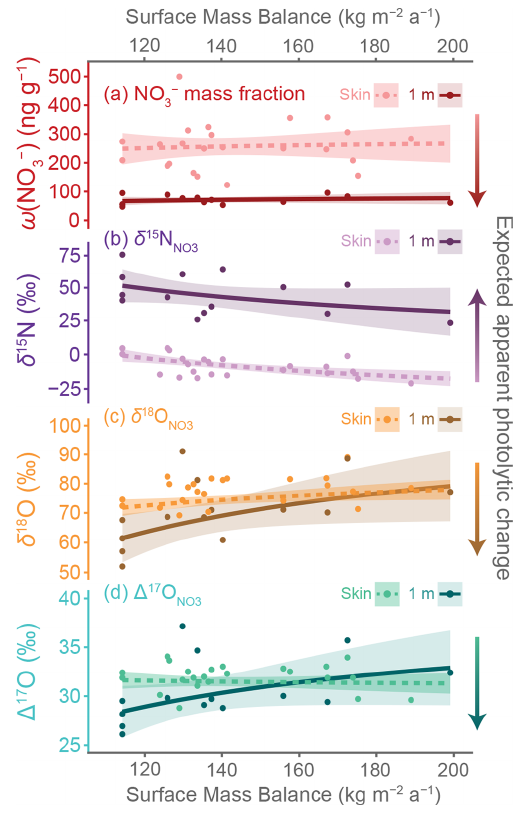
Figure 5. Spatial relationships between nitrate variables and site surface mass balance (SMB). Linear regressions of (a) ω (NO − ) 3 and (b–d) ln(NO − isotopic variable + 1) versus SMB − 1 (Agosta 3 et al., 2019) are shown by dashed (skin layer) and solid (1m depth layer) lines with 95% confidence intervals of the regression shown by shaded zones. The SMB values are mean annual values for 2011– 2013 from MARv3.12.1 (Agosta et al., 2019; Amory et al., 2021). Individual points represent individual samples. The direction of ex- pected changes to NO − variables due to photolysis and associated 3 re-oxidation is indicated by colored arrows. Coefficients and statis- tics for displayed regressions are given in Table